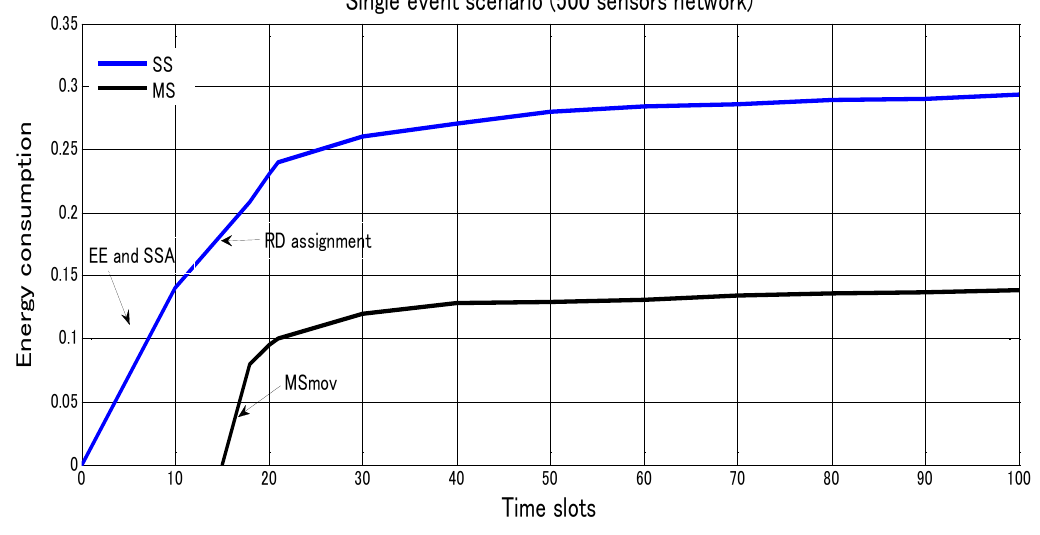
Figure 13. Energy consumption of SS and MS based on the spent time lots under a 3-event scenario with totally 1,000 sensors randomly distributed over a 100*100 network